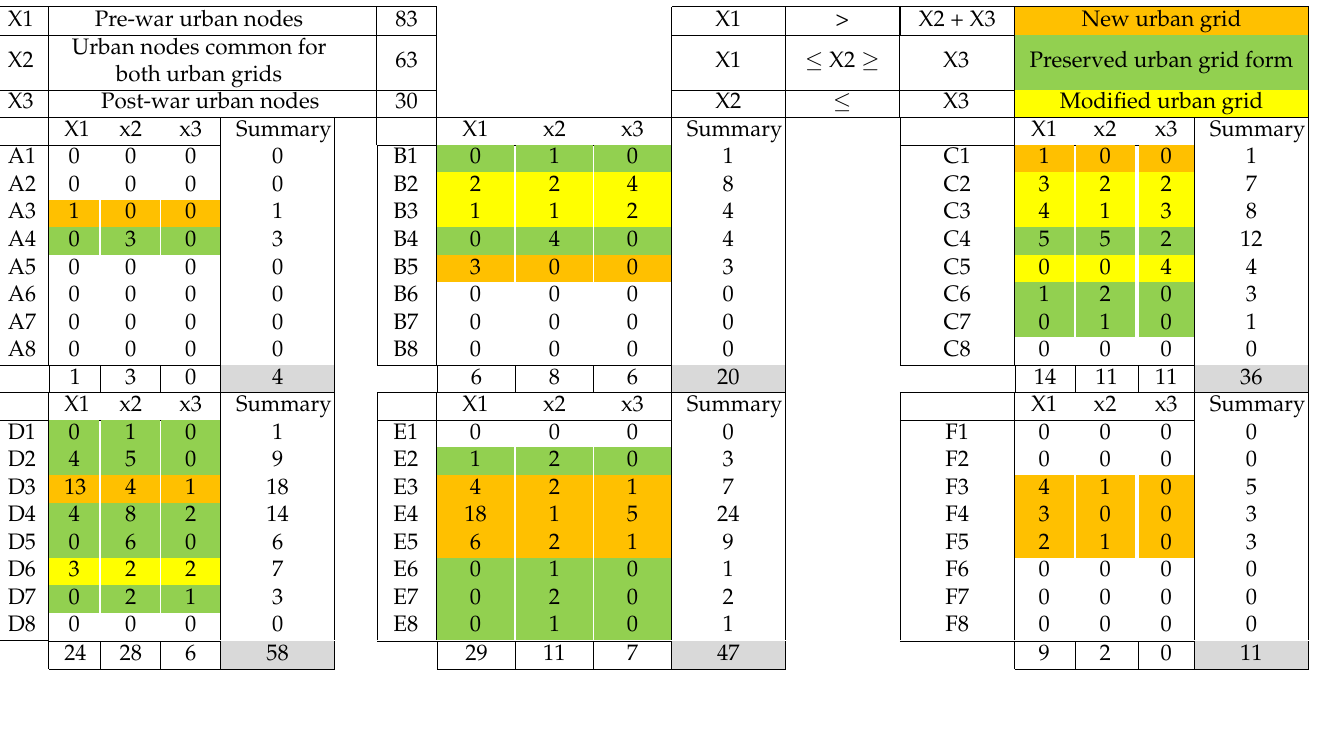
Table 3. The reference of the distribution of nodal points to the polygon mesh. Analysis of nodal points and indication of areas of interference with the urban tissue in the post-war period; prepared by M.